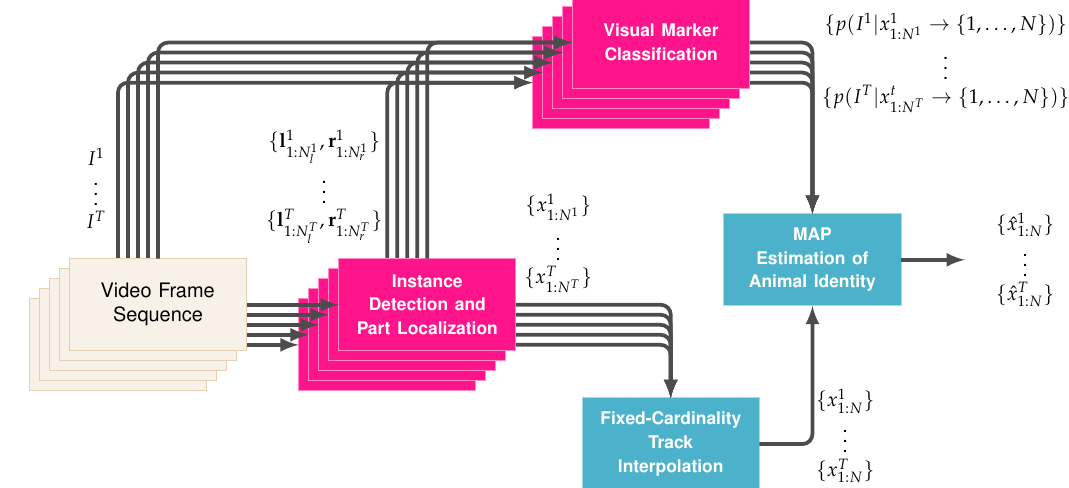
Figure 2. Flow diagram of the proposed method. The input consists of a sequence of consecutive frames { I 1 , . . . , I T } . Information extracted from the frames is used to detect and track individual targets as well as classify their identities using visual marker classification. Finally, the last stage merges tracks with identify likelihoods to achieve maximum a posteriori (MAP) estimation of the location of each } , . . . , { ˆ x T }} target in the frames, denoted {{ ˆ x 1 1: N 1: N